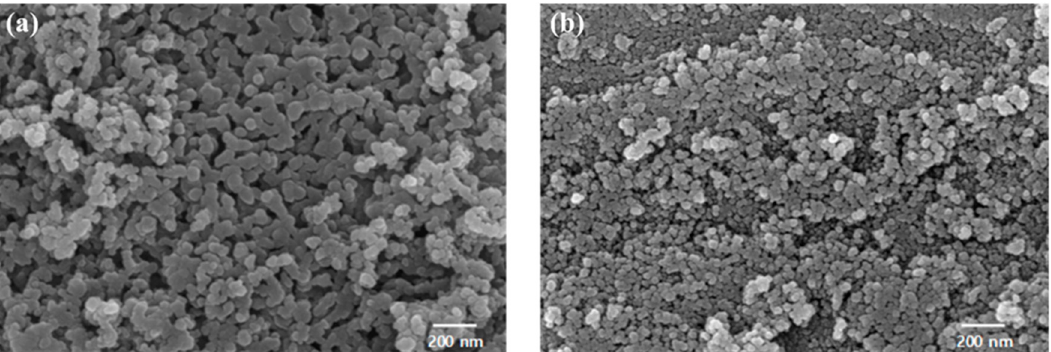
Figure 2. SEM images of ( a ) A-Residue; and, ( b ) A-TiO 2 .